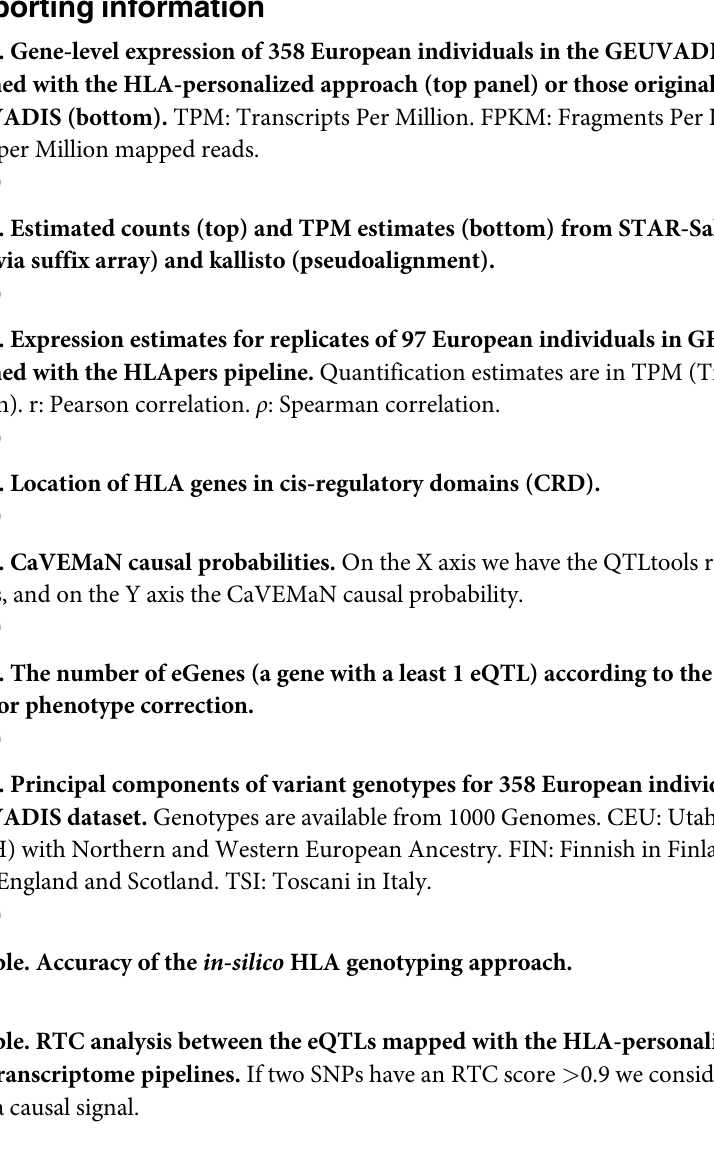
S1 Table. Accuracy of the in-silico HLA genotyping approach. S2 Table. RTC analysis between the eQTLs mapped with the HLA-personalized or refer- ence transcriptome pipelines. If two SNPs have an RTC score > 0.9 we consider that they share a causal signal. S3 Table. RTC analysis between the eQTLs we mapped and previous eQTLs from studies on LCLs or HLA-target studies. If two SNPs have an RTC score > 0.9 we consider that they share a causal